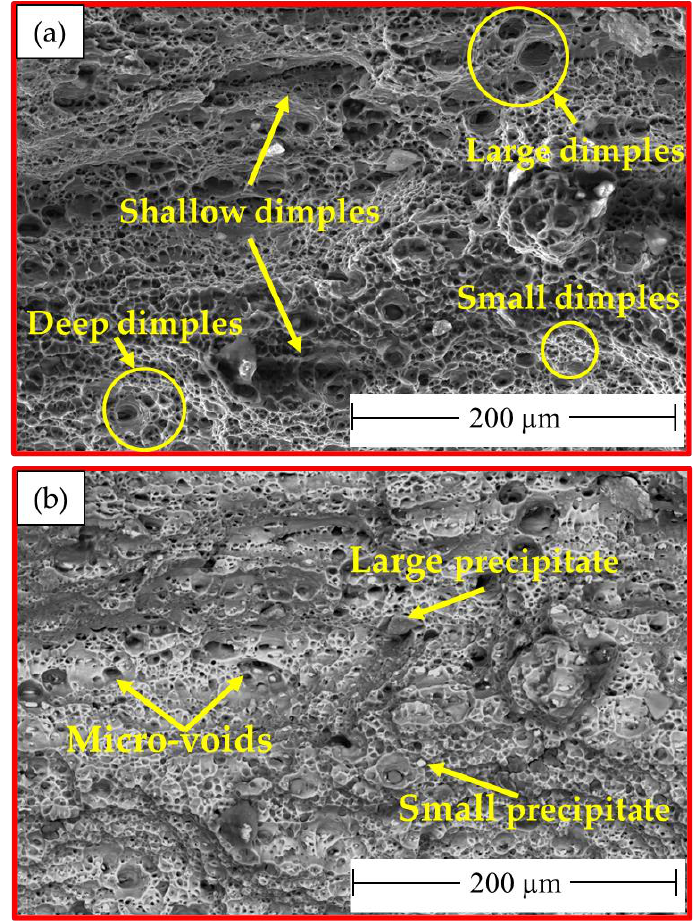
Figure 11. SEM fracture morphologies of AA5052-H32 BM: ( a ) ETD and ( b ) VCD.